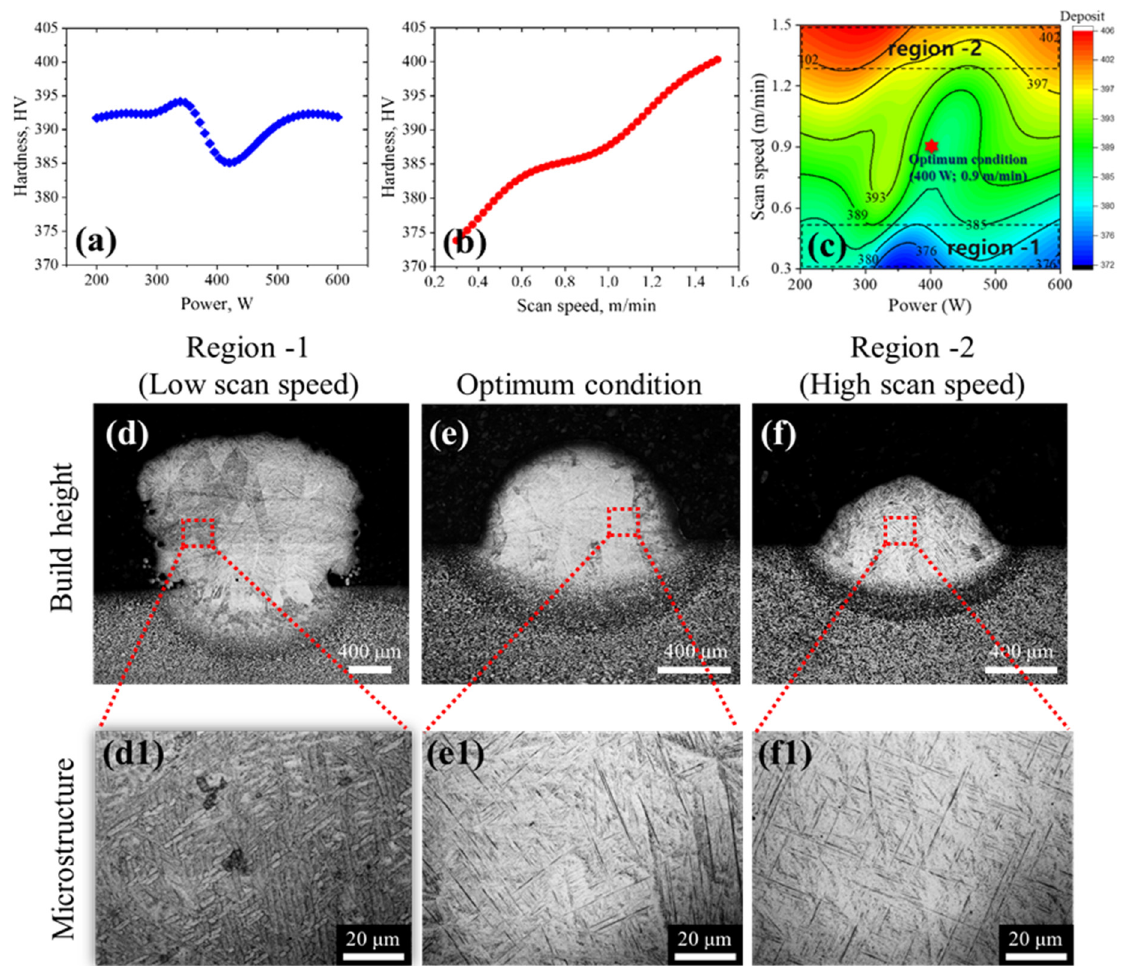
Figure 6. Variation in the hardness values of the deposited materials as a function of the ( a ) power, ( b ) scan speed and ( c ) combined contour plot estimated with ANN. The effect of power and scan speed on deposit height ( d – f ) and microstructure ( d1 – f1 ) of various regions is indicated in ( c ).